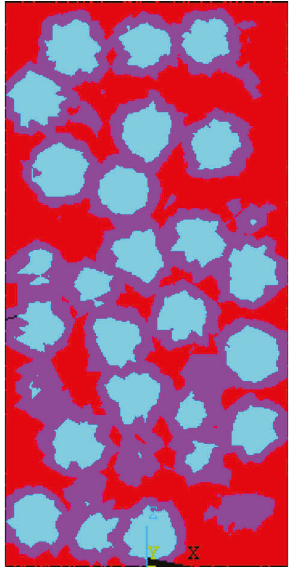
Figure 2: Section of random aggregate.